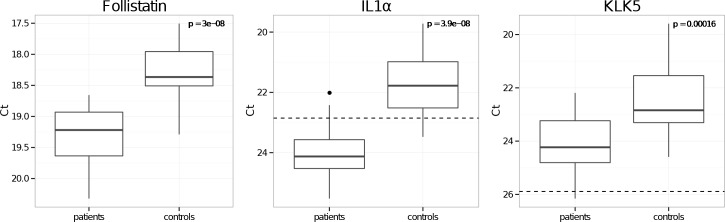
ALS Biomarker candidates.Boxplots showing the CSF levels for follistatin, IL1-alpha and KLK5 for ALS patients and matched controls. The protein levels are compared using the Mann-Whitney U-test and p-values are displayed in the Figures. The limits of detection are indicated by dashed horizontal lines. The y-axes represent Ct-values.